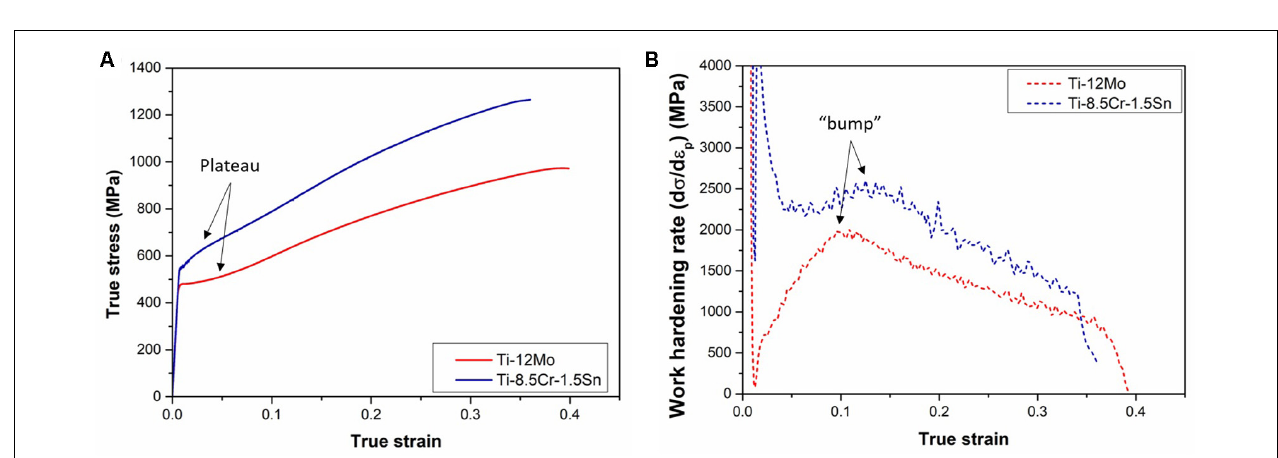
FIGURE 4 | (A) True stress-true strain curves of Ti–12Mo (in red) and Ti–8.5Cr–1.5Sn (in blue) and (B) corresponding strain–hardening rate curves.